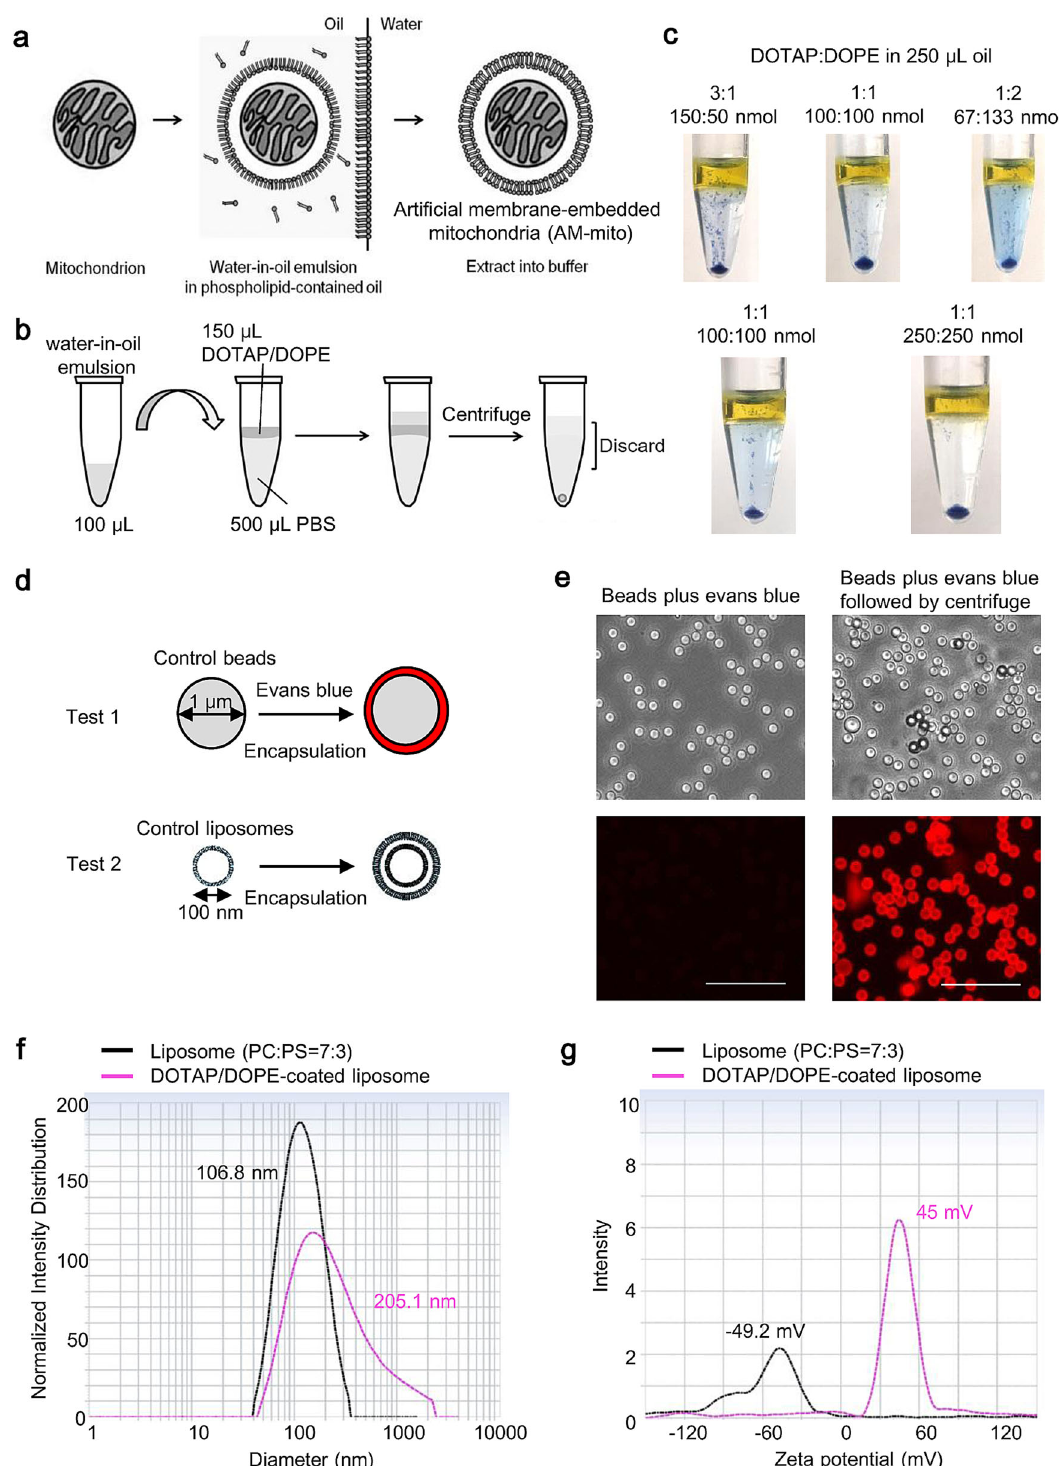
in fl ammation 23 . Moreover, intercellular mitochondrial transfer regulates neuroprotection or neurodegeneration, depending on the context 13,24 . What remains missing from the collective lit- erature to date is how mitochondria become bene fi cial signals and promote neuroprotection. Our present study provides proof-of- principle that mitochondrial encapsulation using cationic lipid DOTAP mixed with DOPE may improve neuroprotection mediated by mitochondrial